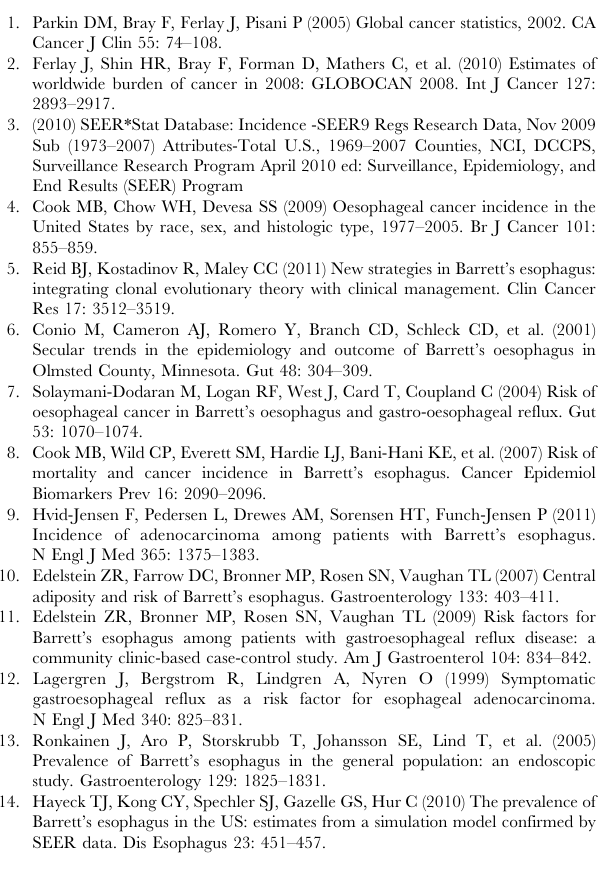
Table S4 Summary of 1645 probe sets in BE versus NE (P , 1.12E-06 with 2-fold or greater change). (XLSX) Table S5 Summary of 782 probe sets in BE versus NC (P , 1.12E-06 with 2-fold or greater change). Table S6 Microarray-based and qRT-PCR-based ex- pression results for genes selected for validation in discovery samples and independent replication in new samples. Table S7 Common genes significantly differentially expressed (P , 1.12E-06 with 2-fold or greater change in expression) in BE vs NE and BE vs NC tissues comparisons. Table S8 Gene function and pathway-based analyses of common genes significantly differentially expressed in BE vs NE and BE vs NC tissues